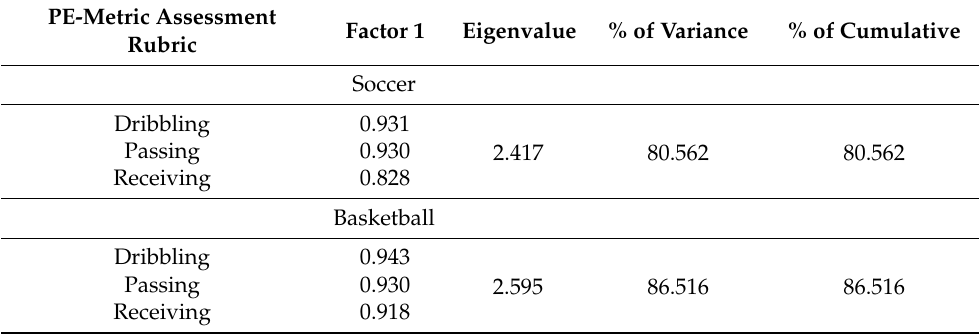
Table 2. Exploratory factor analyses of the manipulative skill assessments: factor loading from the structure